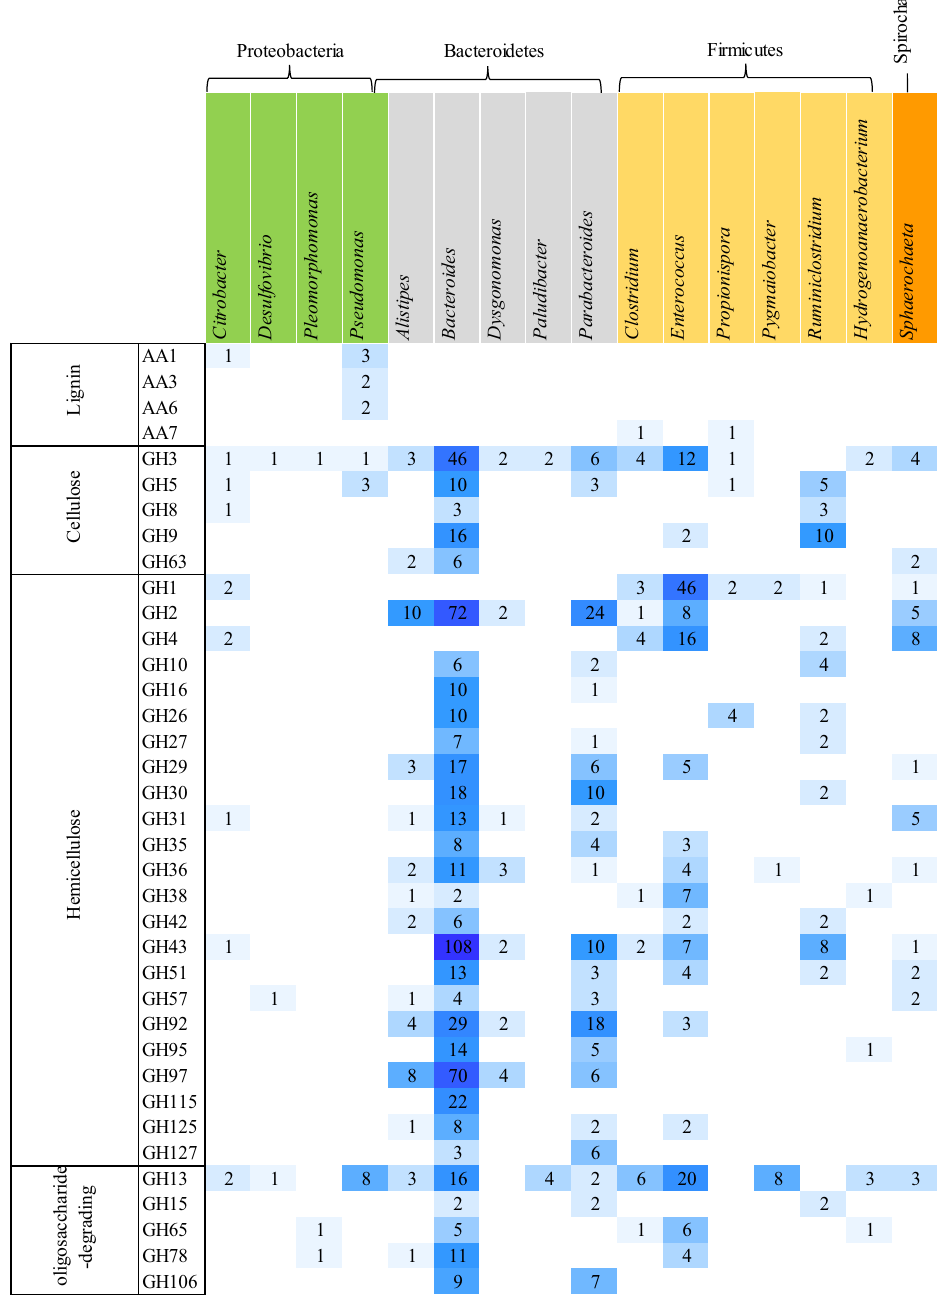
Figure 5. Heat map showing the distribution of glycoside hydrolase (GH), and auxiliary activities (AA) families in the abundant genera. CAZy families are grouped according to their activities on major components of plant cell walls. Only GH families targeting (hemicellulose and cellulose), and AA families targeting lignin are considered. Only genera with ten or more GHs are presented. Proteobacteria are depicted in green, Bacteroidetes in gray, Firmicutes in yellow, and S pirochaetes in